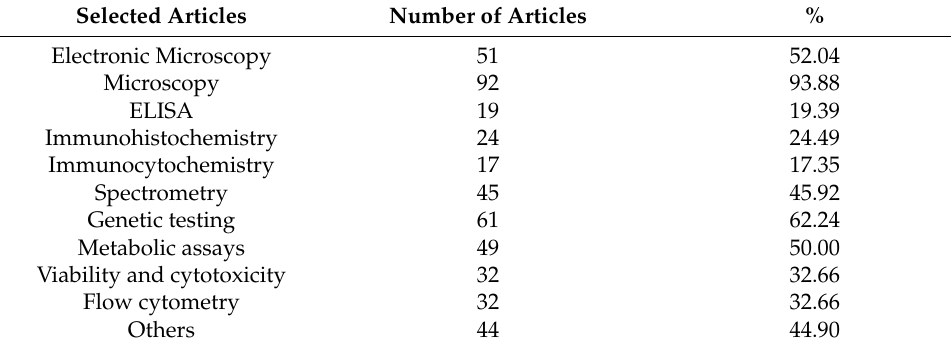
Table 1. Types of in vitro